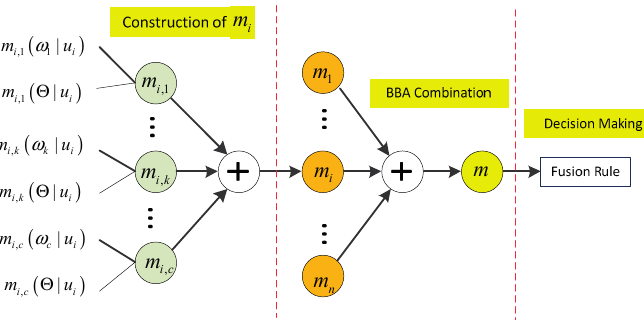
Figure 2. Derivation process of the proposed approach, in which ⨁ denotes the Dempster BBA combination operation, (cid:1865) global BBA of all